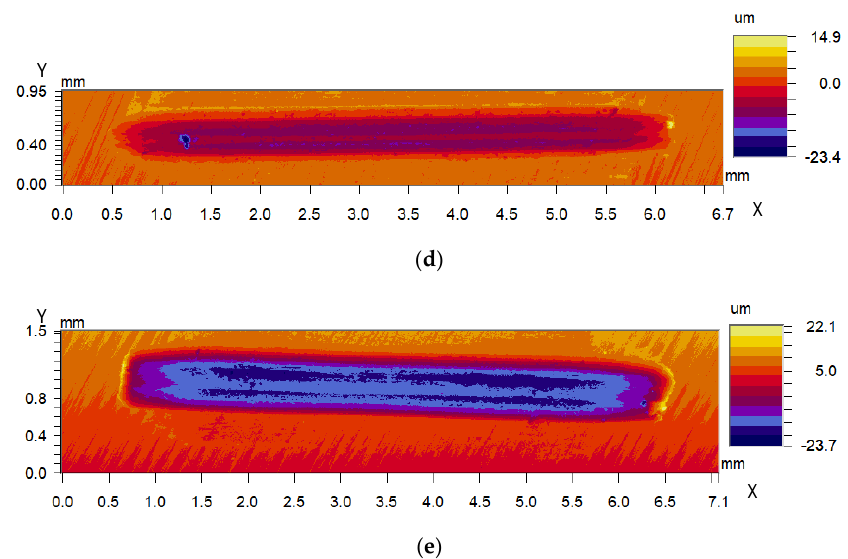
Figure 12. Three-dimensional white-light interference images of wear traces morphology of untreated specimens tested at: ( a ) 50 N / 83.3 mm · s − 1 / 298 K, ( b ) 100 N / 83.3 mm · s − 1 / 298 K,